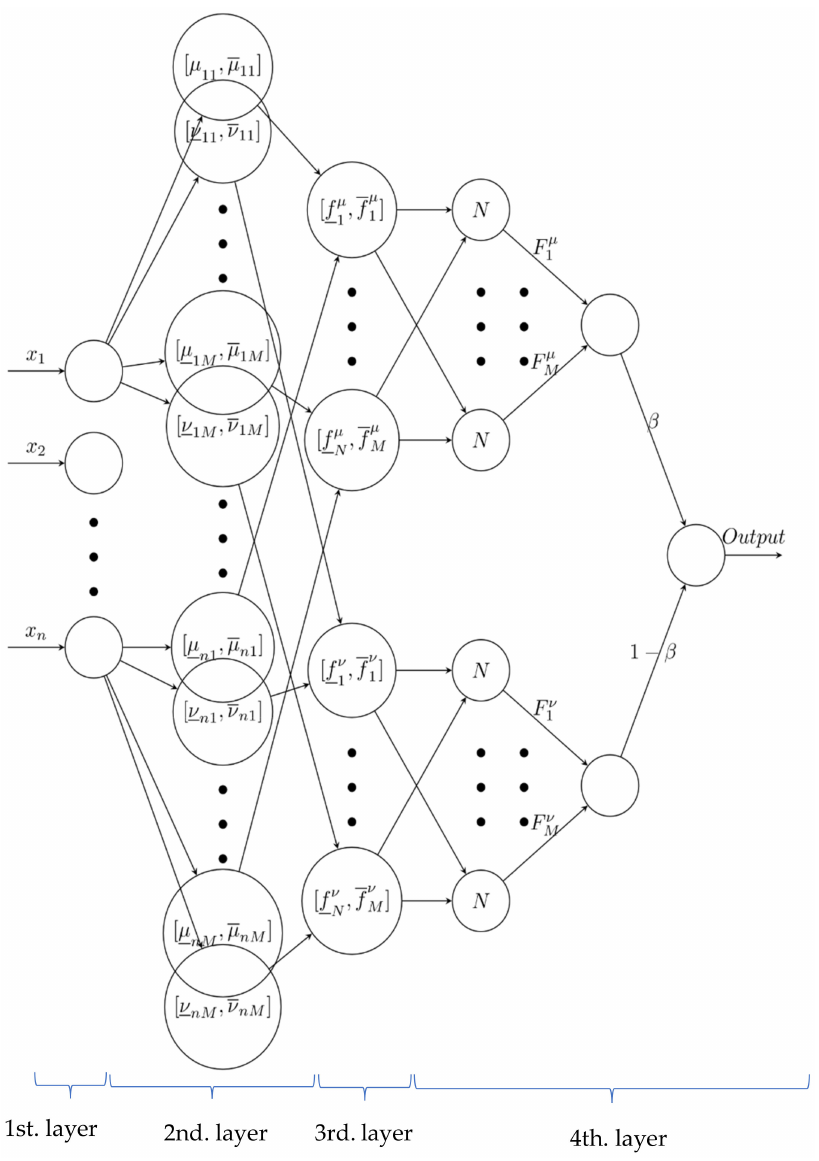
Figure 1. Structure of